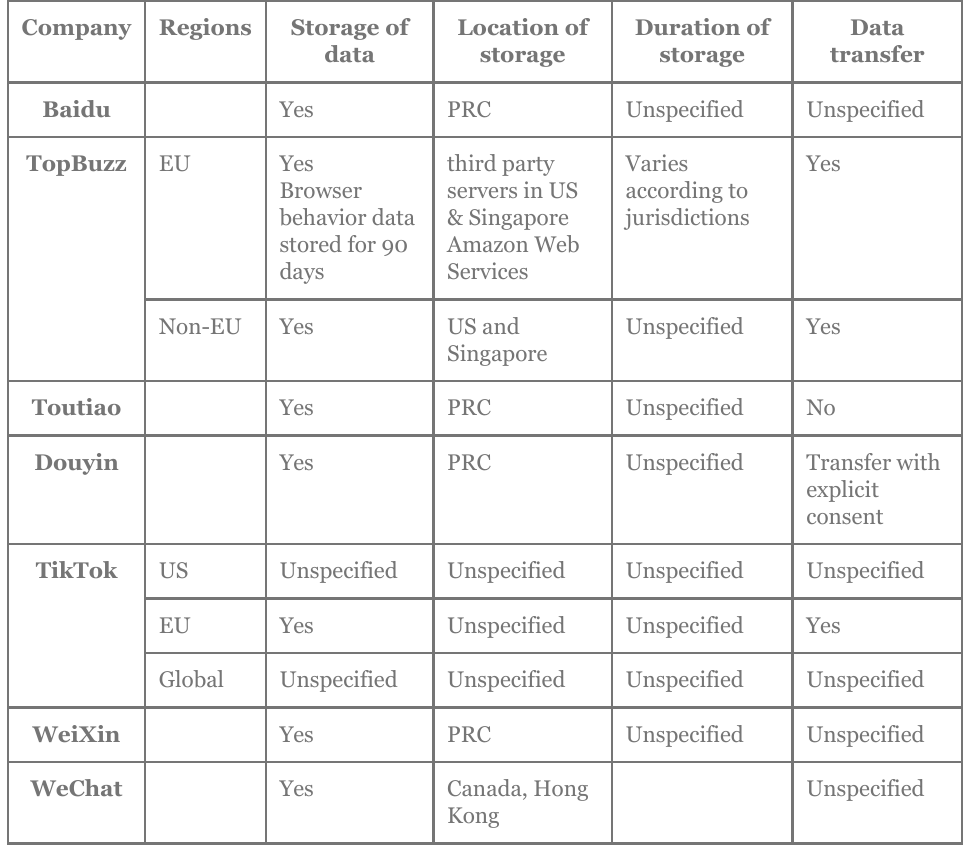
Table 2: Storage and transfer of user